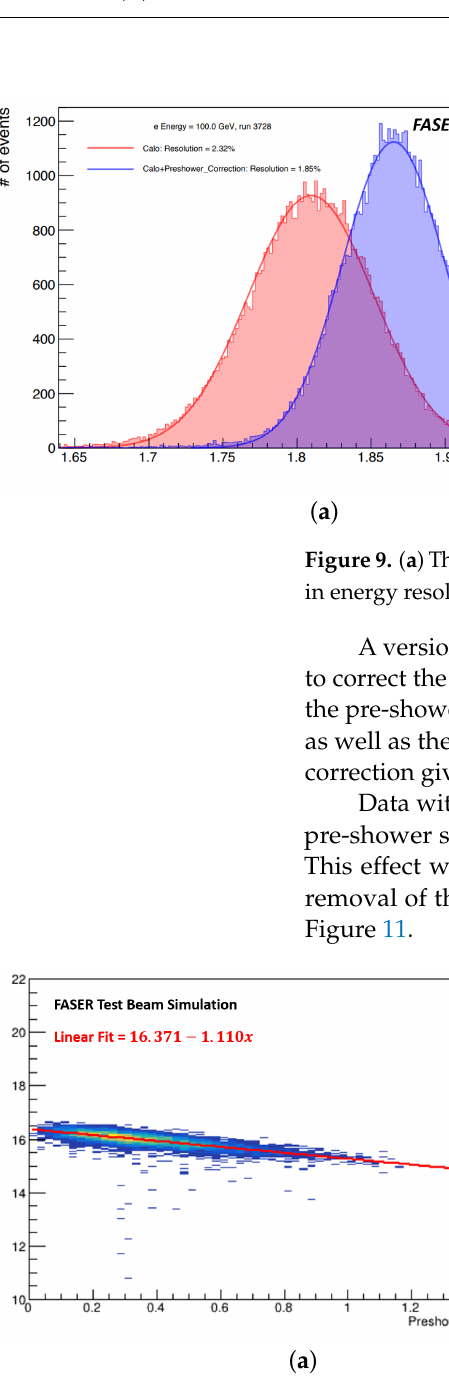
Figure 10. The distribution of deposited energy in the pre-shower versus the calorimeter for a simulated 100 GeV electron ( a ) before and ( b ) after the pre-shower correction has been